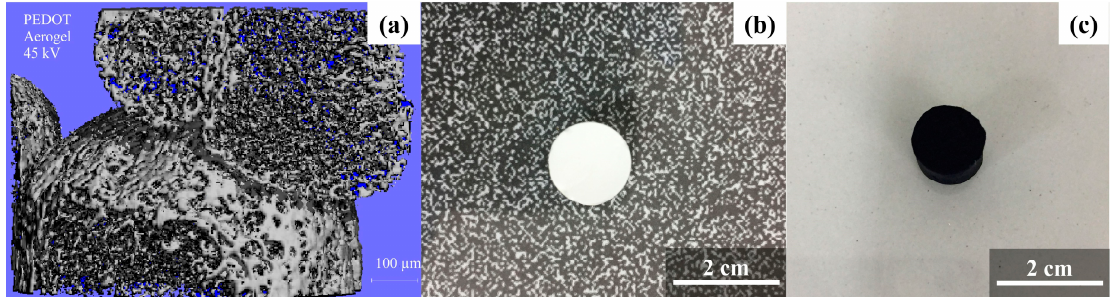
Figure 3. Porous material microtomography (micro-CT) image ( a ) and aerogel images before ( b ) and after conductive polymer (i.e., poly(3,4-ethylenedioxythiophene) (PEDOT)) modification ( c ). Reproduced from [52,53] under Elsevier Copyright Clearance Center (CCC) licenses.